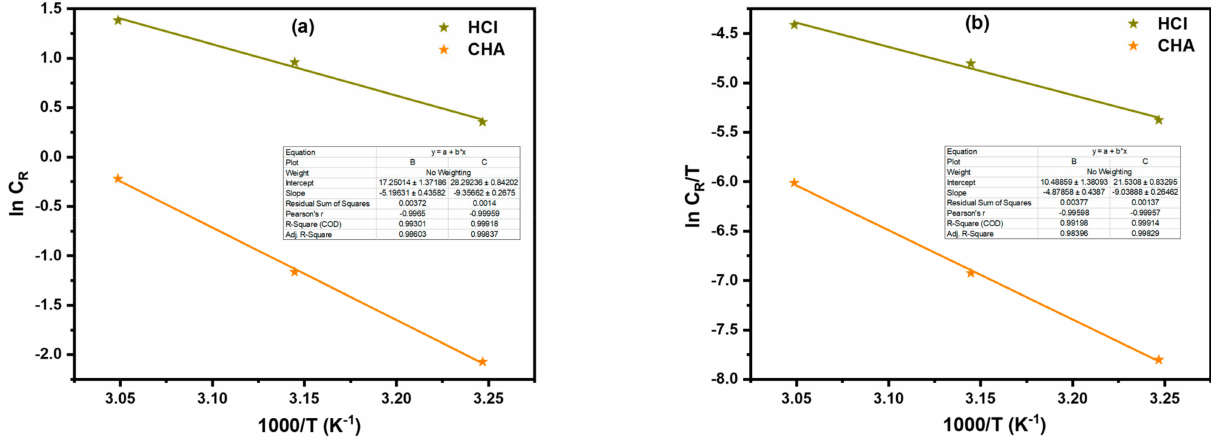
Figure 3. Arrhenius ( a ) and Arrhenius transition ( b ) curves for the corrosion rate of mild steel coupons immersed in the acid solution without and with the extract CHA of Artemisia herba-alba